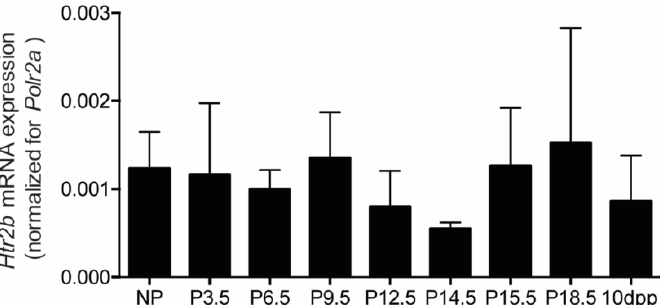
Figure 7. Pancreatic islet Htr2b mRNA expression signals during pregnancy and lactation. mRNA was extracted from isolated islets at different time points of pregnancy and 10 days postpartum ( n = 3 to 9 independent islet preparations for each time point). Htr2b mRNA was normalized for Polr2a expression in the same tissue sample; islet expression levels were expressed as a ratio of the measured placental mRNA signal.